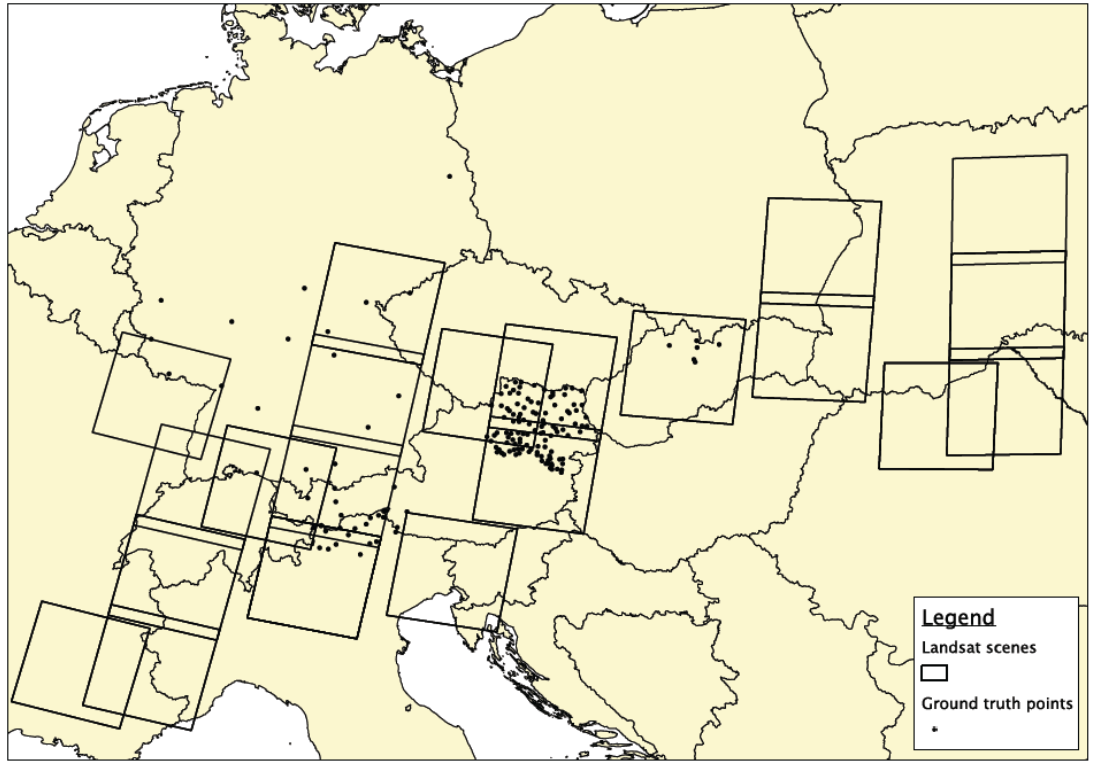
Figure 1. Location distribution over the area of interest of the Landsat scenes (indicated as squares) and ground truth data (indicated as points) for the season 2005/2006 exploited in the validation of the EURAC algorithm.